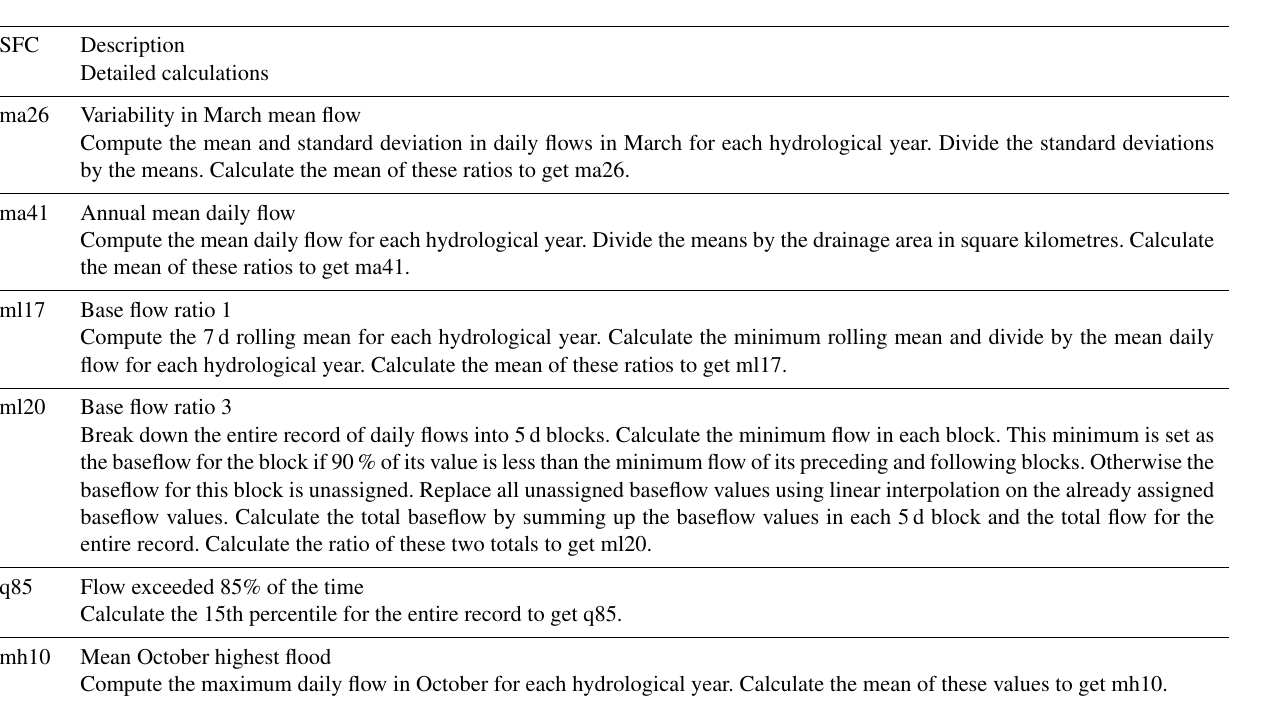
Table A2. Detailed computations for the 18 selected streamflow